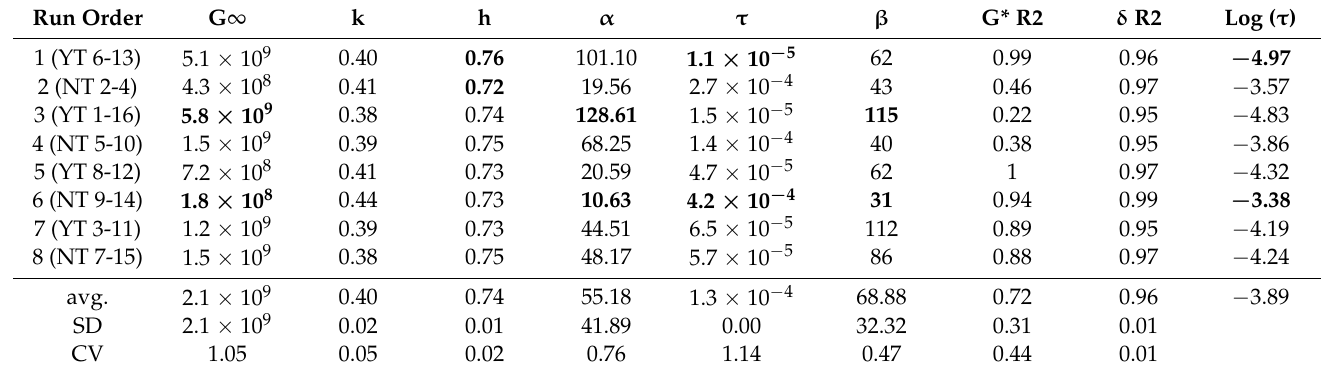
Table 12. The 2S2P1D model parameters for all runs for 160/220_I. Statistically significant differences between runs are denoted in bold.